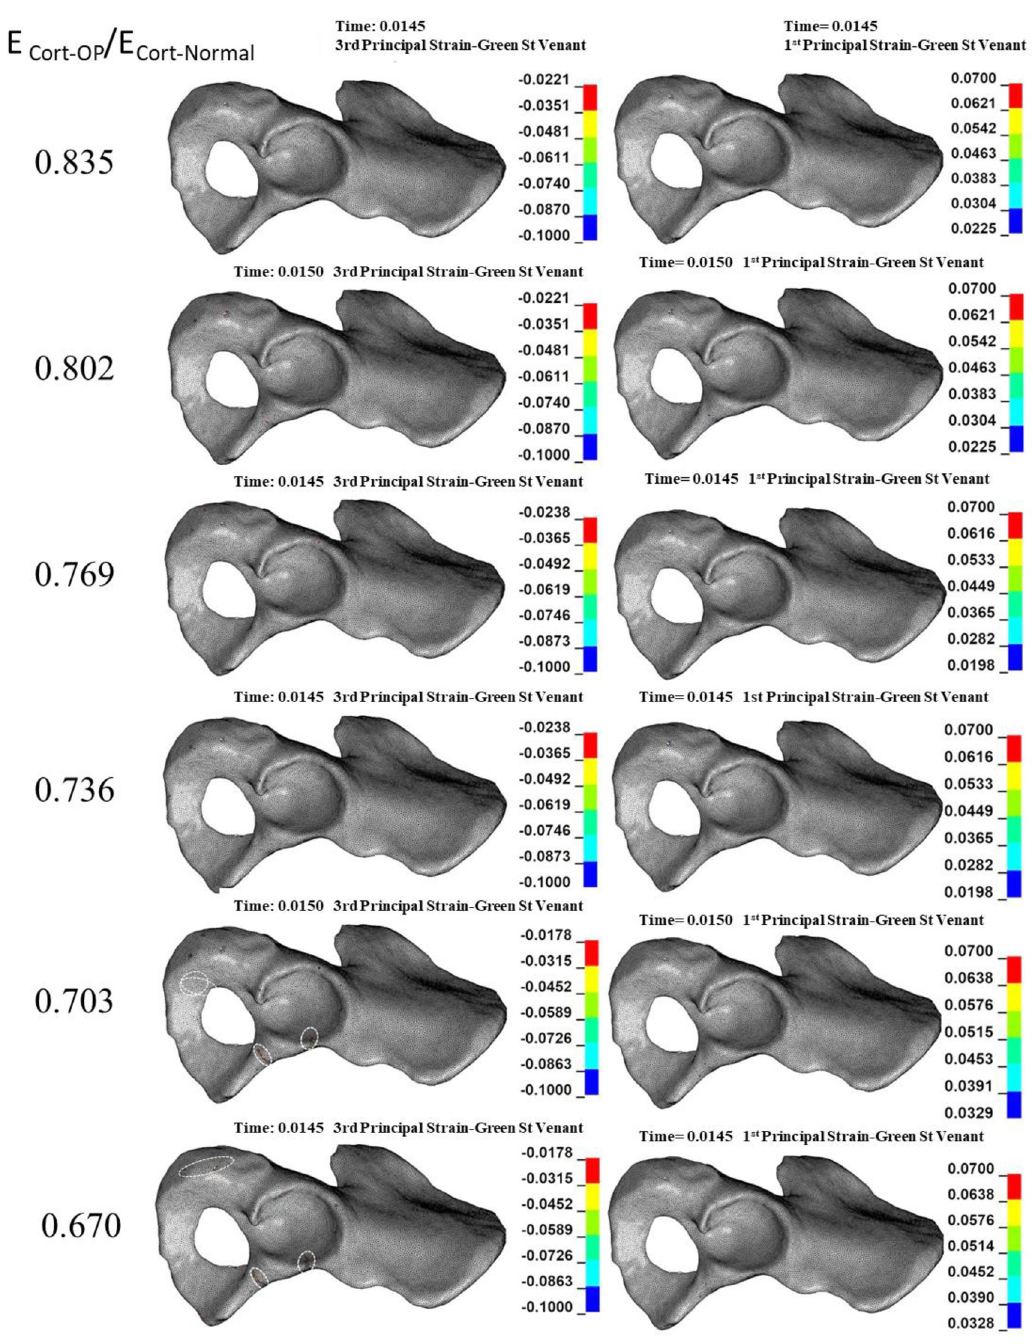
Fig 5. Effect of reduction in cortical elastic modulus (E cort ) on the compressive (left column) and tensile (right column) cortical bone failure. The tensile and compressive strain concentrations were only minor. Dashed circles: anatomical landmarks with a high risk of bone